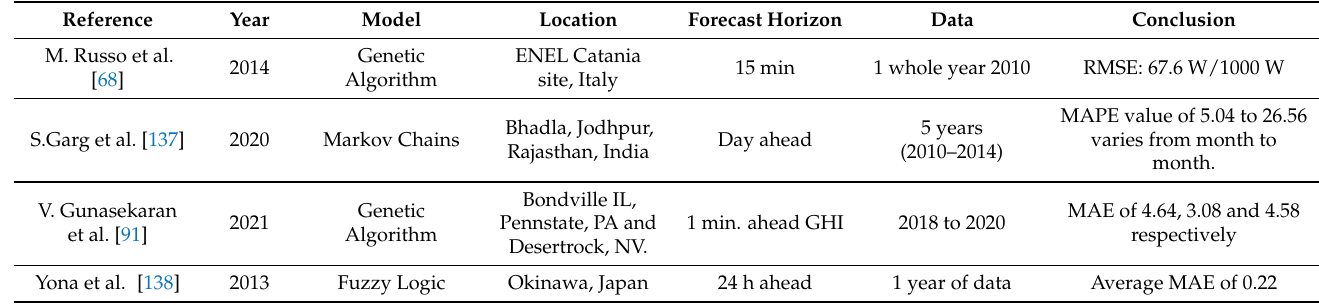
Table 8. Summary of special artificial intelligence models.